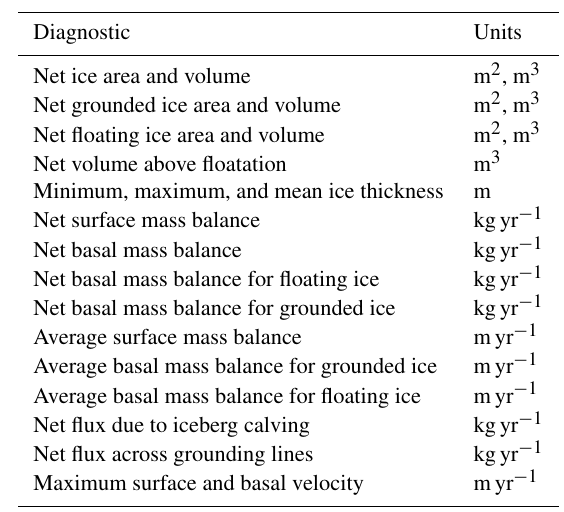
Table 2. Standard model diagnostics available for an arbitrary num- ber of predefined geographic regions.